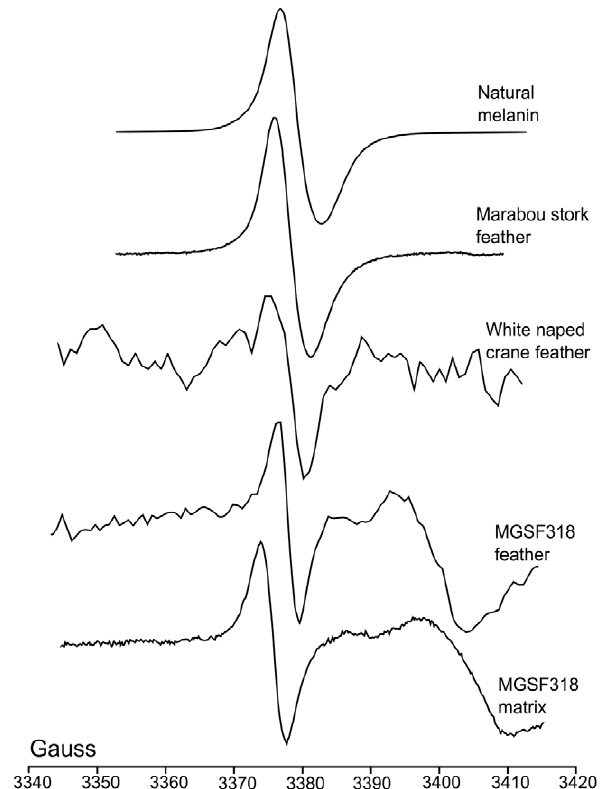
Figure 5. EPR spectra of Sepia officinalis eumelanin, Gansus yumenensis and extant feathers. Samples taken at room tempera- ture. The Gauss scale (abscissa) is approximate due to the slight variations that occur in the frequency of the incident radiation; amplitudes are arbitrary.